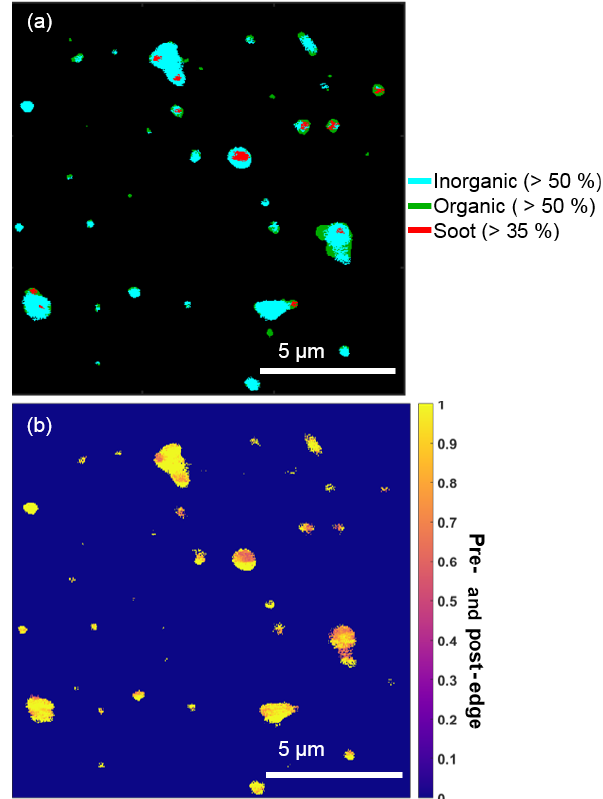
Figure 4. Representative STXM-NEXAFS map from 26 February nighttime showing (a) the distributions of inorganic dominant (blue, >50% by mass), organic carbon dominant (green, >50% by mass), and soot (red, sp 2 >35%) and (b) the ratio of inorganic (pre-) and organic (post-edge) components between populations of individual particles sampled during a period with a high fraction of organic + sulfate